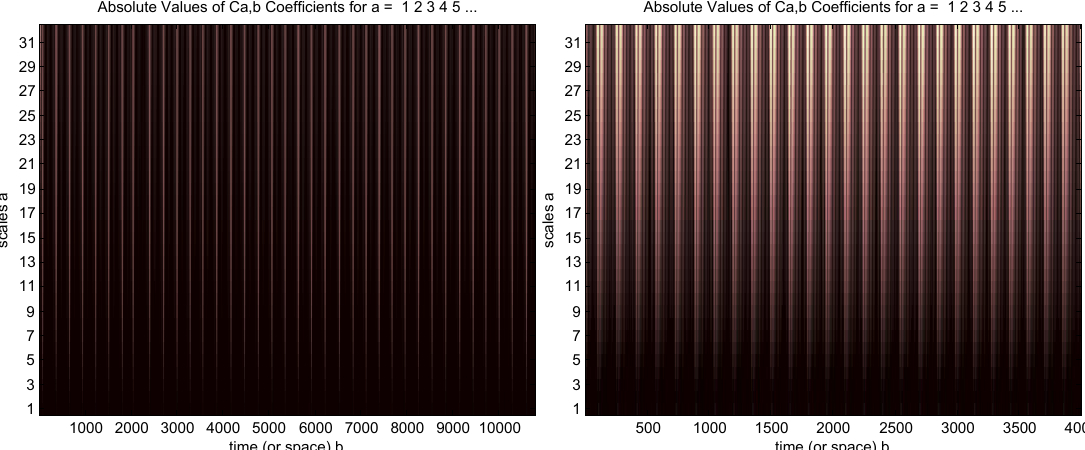
Figure 5. Wavelet for ECG signal ( left ) and PPG signal ( right ) shown in Figure 1.